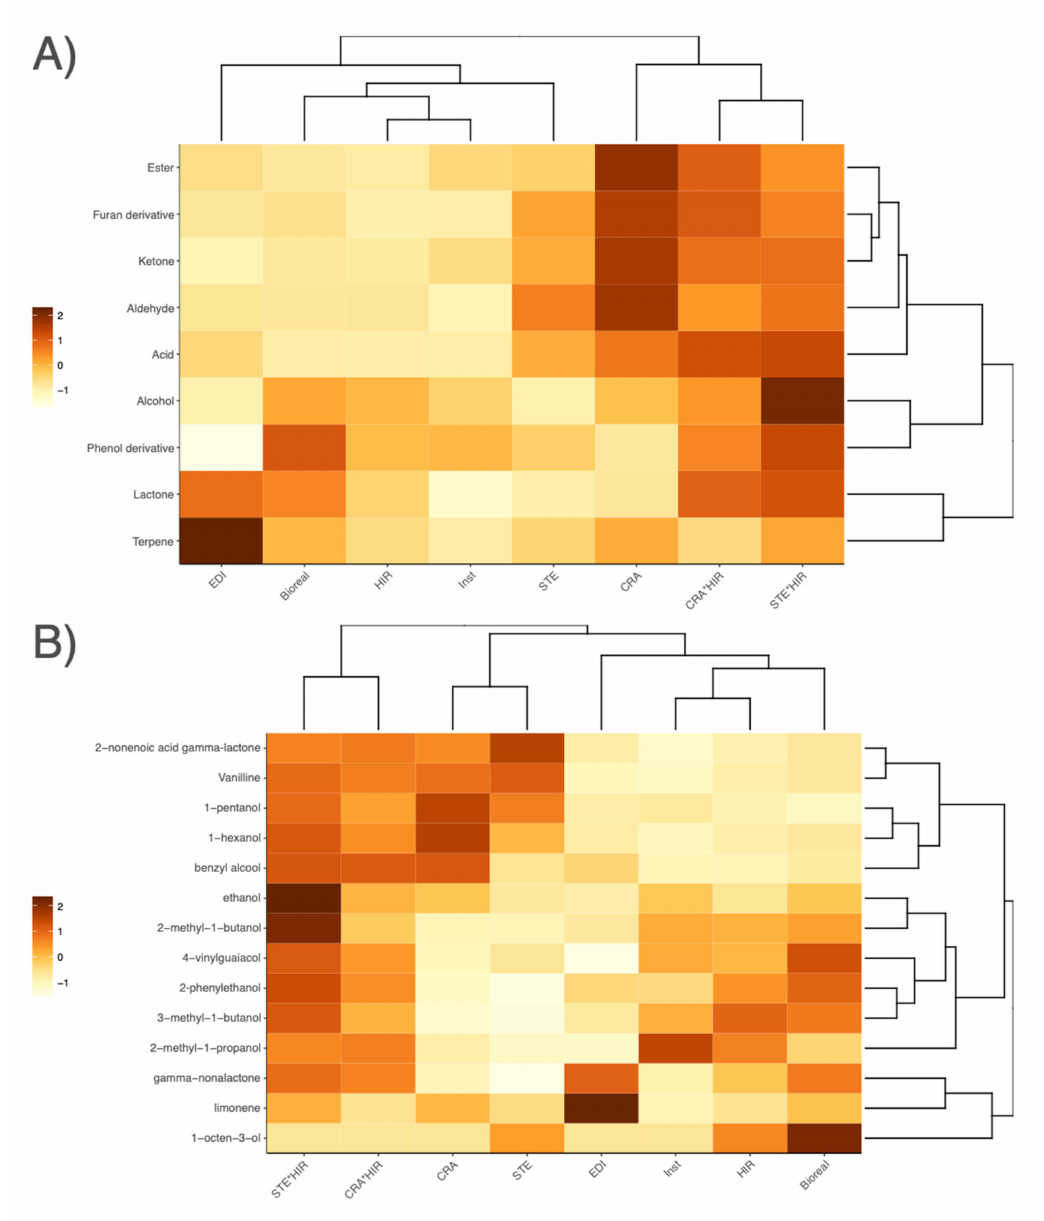
Figure 7. Heat maps in the three sourdough breads (CRA, EDI, STE), the two mixed breads (CRA*HIR, STE*HIR), and the three yeast breads (Bioreal, HIR, Inst) of ( A ) the relative content of the chemical classes of the 38 aroma compounds analyzed and ( B ) the relative content of the aroma compounds whose classes were shared among all the breads (alcohols, lactones, phenol derivative, and terpene). (“CRA”, “EDI”, and “STE” refer, respectively, to the bakers Collectif Cravirolla, Edith Brissiaud, and St é phane, and “HIR”, “Bioreal”, and “Inst” refer, respectively, to the three commercial